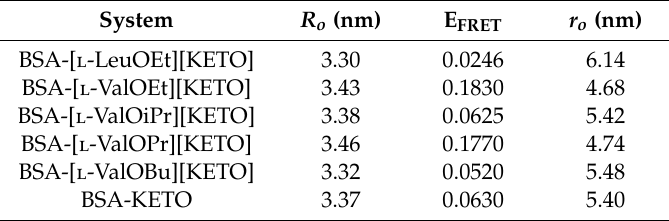
Table 5. Steady-state FRET parameters of the BSA-[AAOR] [KETO] interactions.